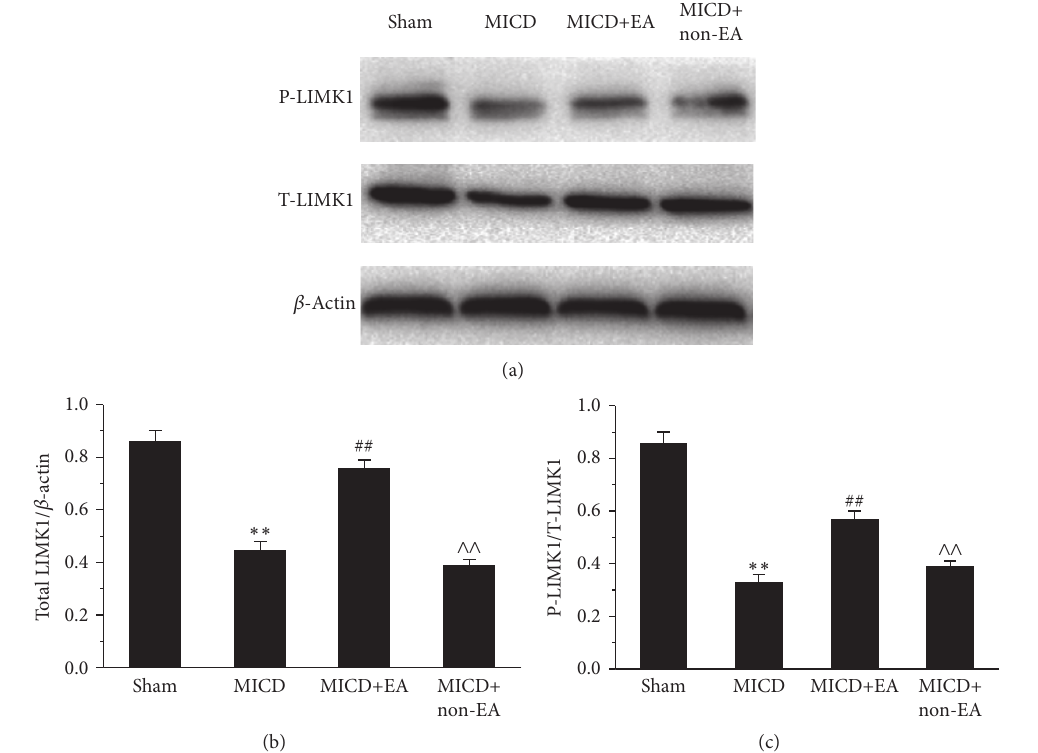
Figure 6: EA amplified the LIMK1 level in the hippocampus CA1 pyramidal cells. (a) The expression of total LIMK1 and phosphorylated LIMK1 was evaluated using western blotting. (b and c) Histogram shows significant difference of the levels of P-LIMK1 and phosphor-LIMLK1 in each group. Data are means ± SEM ( 𝑛 = 6 /group; ∗∗ 𝑝 < 0.01 versus the Sham group; ## 𝑝 < 0.01 , # 𝑝 < 0.05 versus the MICD group; ∧∧ 𝑝 < 0.01 , ∧ 𝑝 < 0.05 versus the MICD+EA